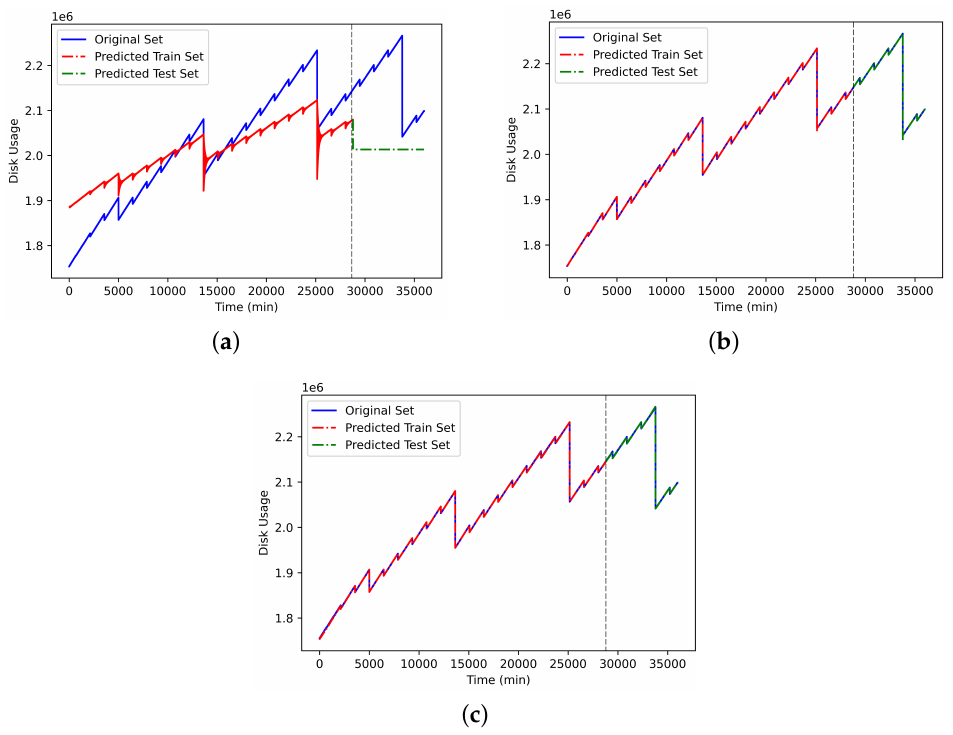
Figure 5. Graphics for data type “disk usage”: ( a ) moving average; ( b ) bidirectional LSTM; ( c ) pro- posed (moving average +